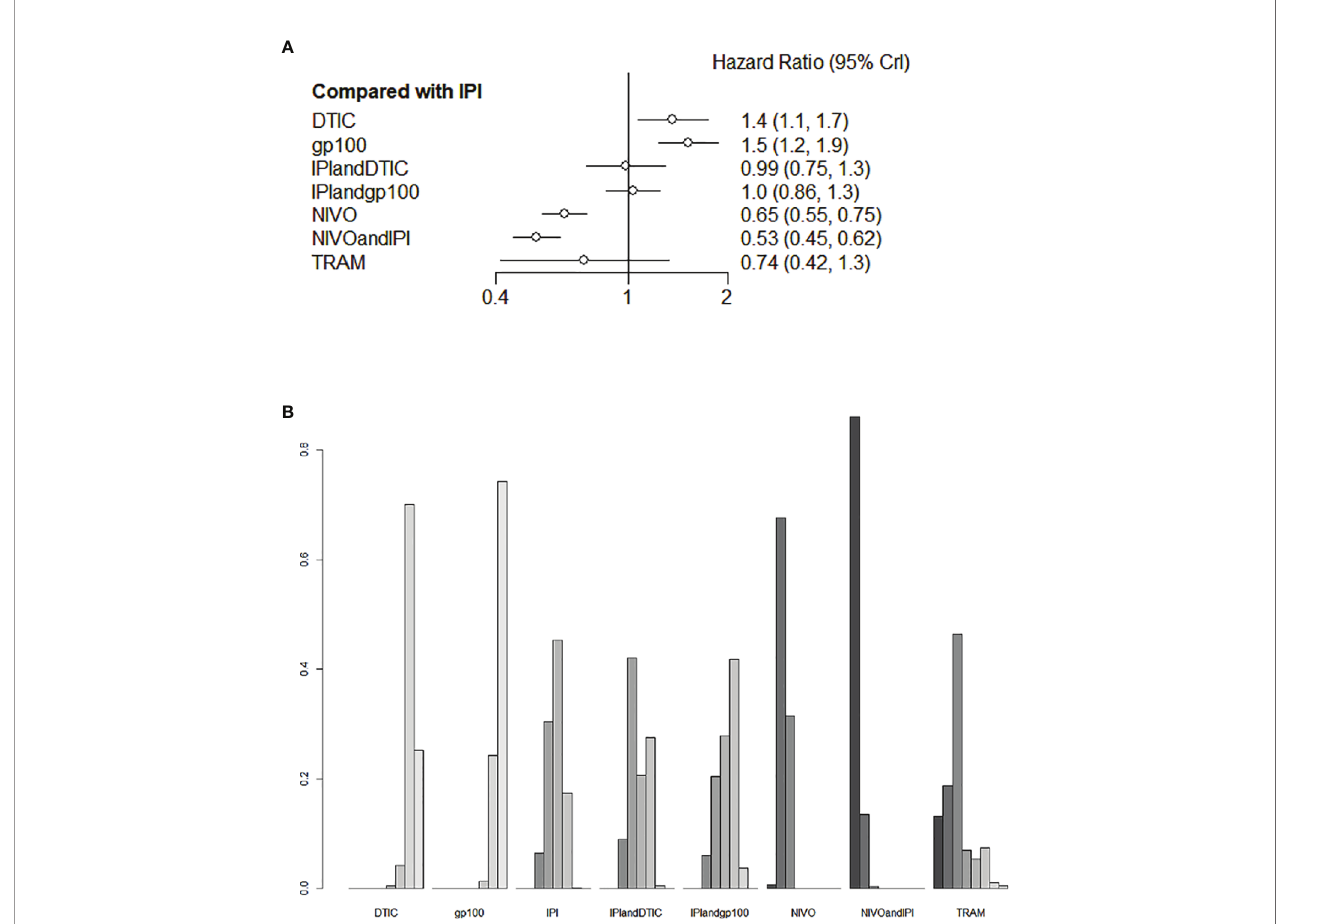
FIGURE 4 | Direct and indirect comparisons for OS (A, B) among IPI+DTIC, IPI+gp100, DTIC, IPI, gp100, NIVO, NIVO+IPI,